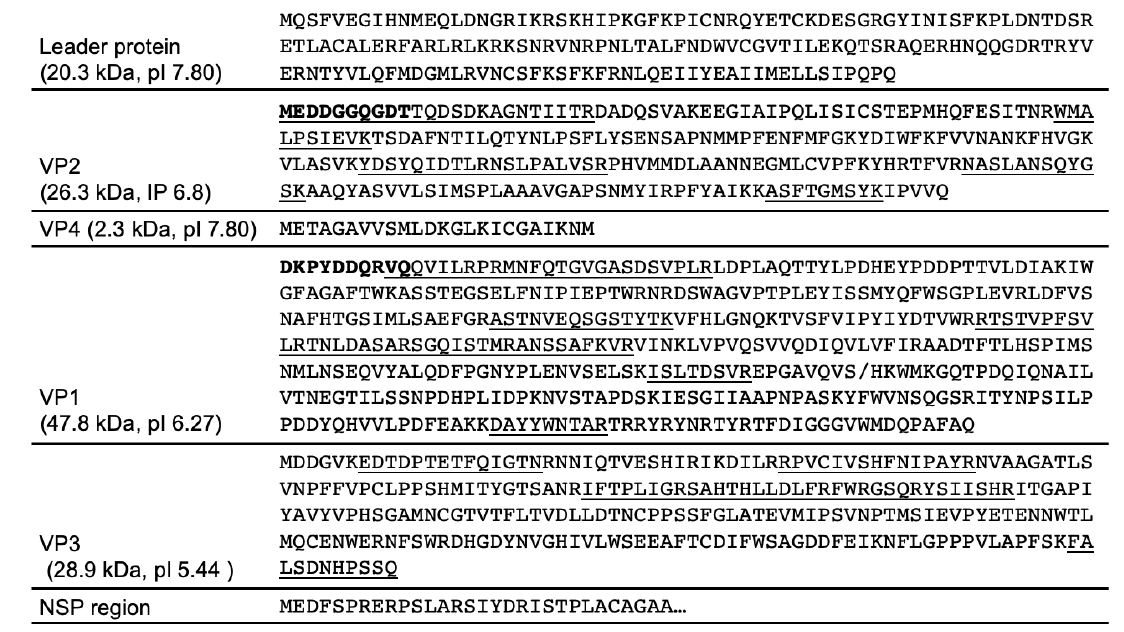
Figure 7. Processing of the La Jolla virus (LJV) polyprotein in the structural protein region of strain LJV-Ds-OS20. The C-terminal cleavage site of the leader protein was deduced from the N-terminus of VP2. The N-terminus of VP2 was determined both by N-terminal sequencing (NTS) and peptide mass fingerprinting (PMF). The precise C-terminus of VP2 was not resolved by PMF. Peptides of a hypothetical VP4 were not detected in our LJV particles. The N-terminus of a VP4 related peptide seems to be reliable determined based on the detectable VP2 peptide located just upstream of the supposed N-terminus and due to a conserved Q/ME cleavage site. The unusual C-terminal cleavage site between VP4/VP1 is deduced by the N-terminus of VP1, which was determined by NTS but not PMF. Neither the exact C-terminus of VP1 nor the N-terminus of VP3 was experimentally mapped. However, by detecting neighboring peptides and a typical Q/MD cleavage site, we can make a prediction. The detection of a VP3 C-terminal peptide lacking basic amino acid residues and the typical cleavage site allowed the precise mapping of the VP3 C-terminus. Amino acids shown in bold were determined by NTS and underlined sequences are peptides detected by PMF. Protein names are provided together with the calculated molecular weights and isoelectric points (pI).